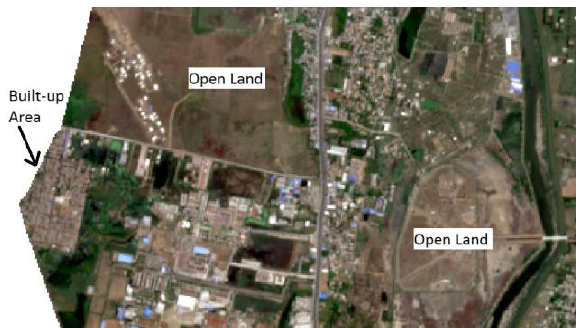
Figure 4. Similar tone for built-up area and open land in south western part of the study area